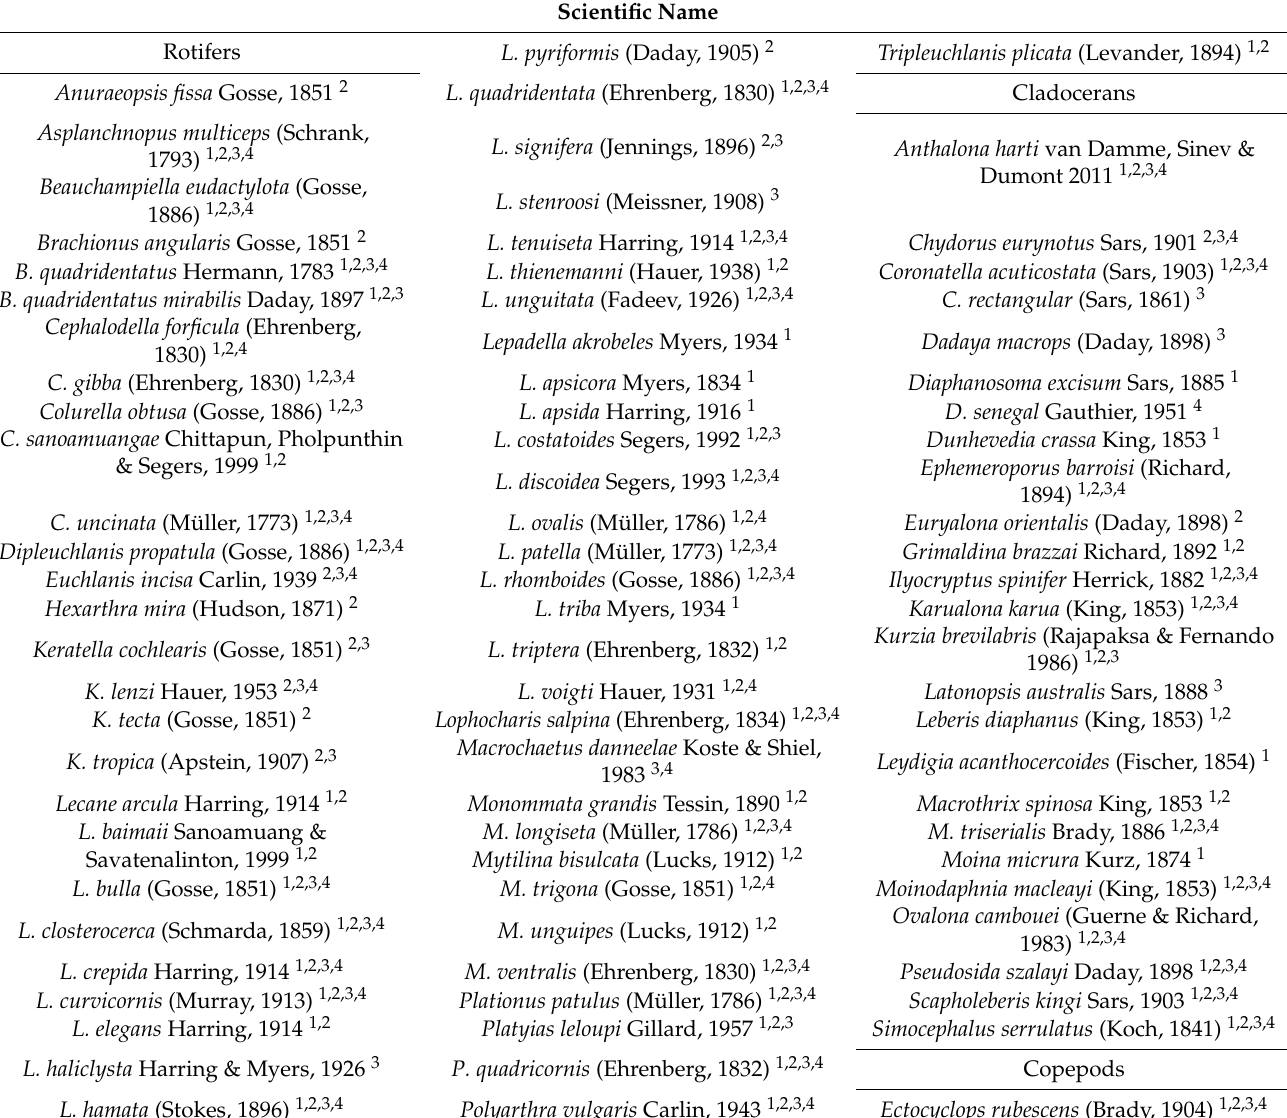
Table 1. The list of zooplankton species in RF-NPA and RF-PA. The numbers 1, 2, 3, and 4 represent the first sampling RF-NPA, the second sampling RF-NPA, the first sampling RF-PA, and the second sampling RF-PA,